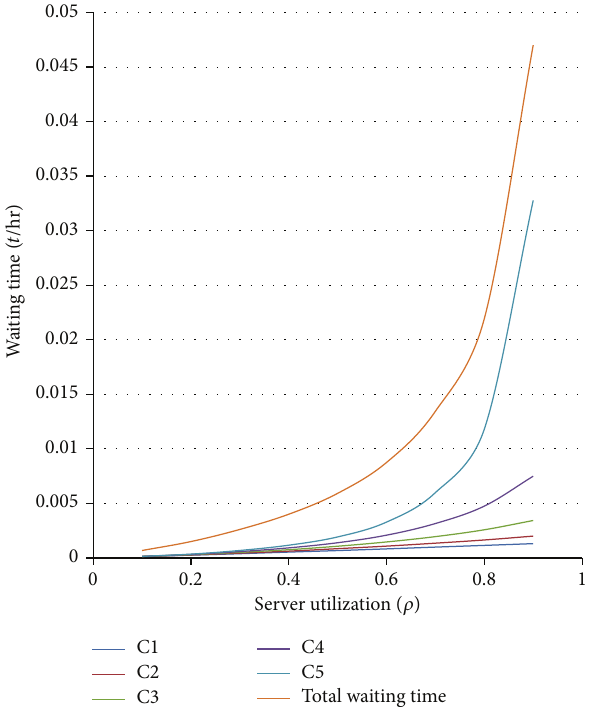
Figure 4: Performance of the five classes waiting with the total waiting time.